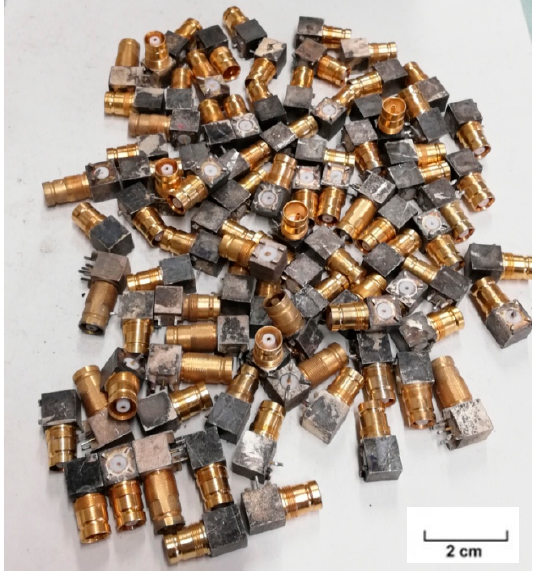
Figure 1. First sample of connectors with partial gold-plated surface.